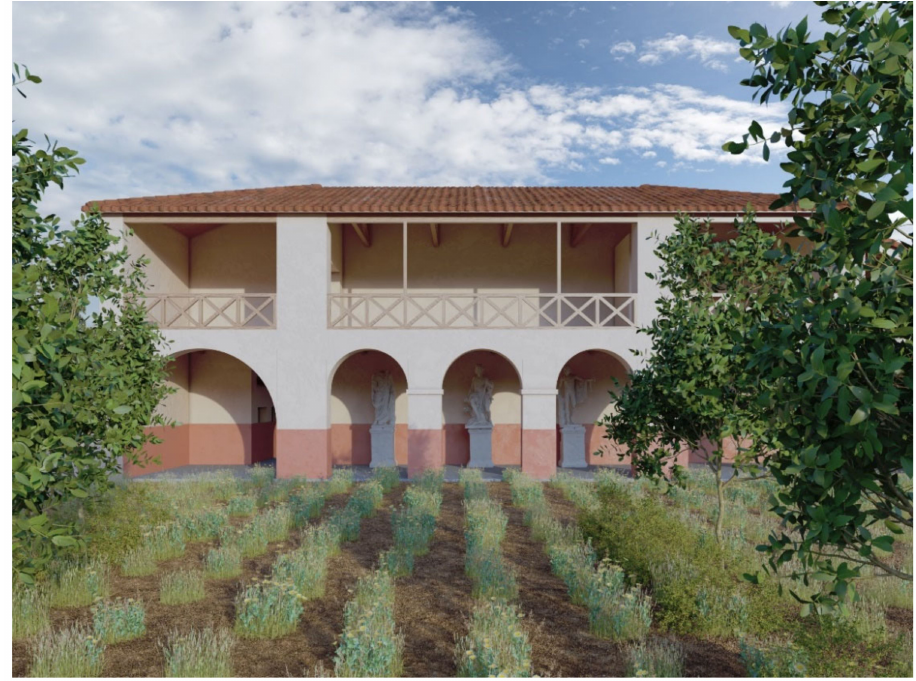
Figure 7. Reconstructive hypothesis of the monumental complex. Rendering of the